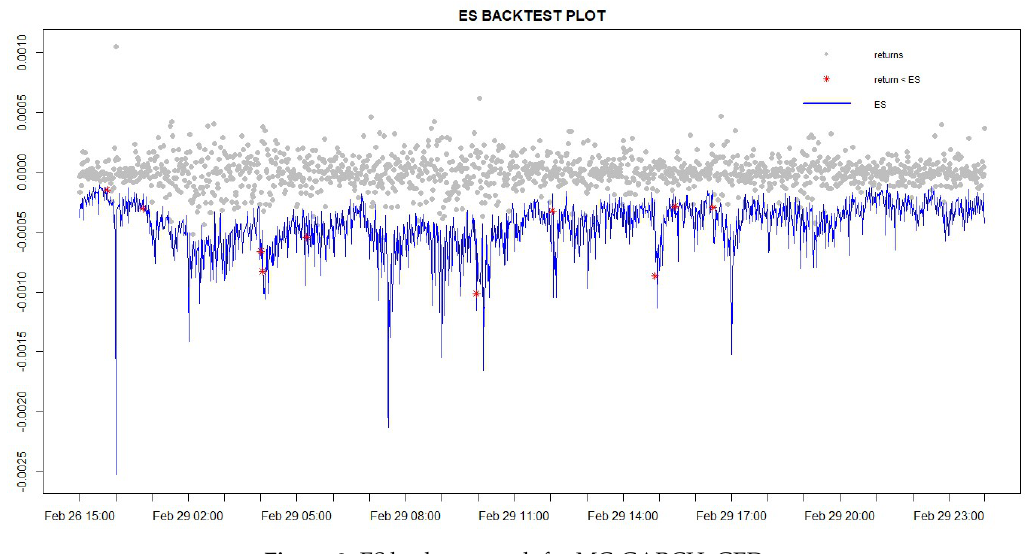
Figure 9. ES backtest graph for MC-GARCH_GED.